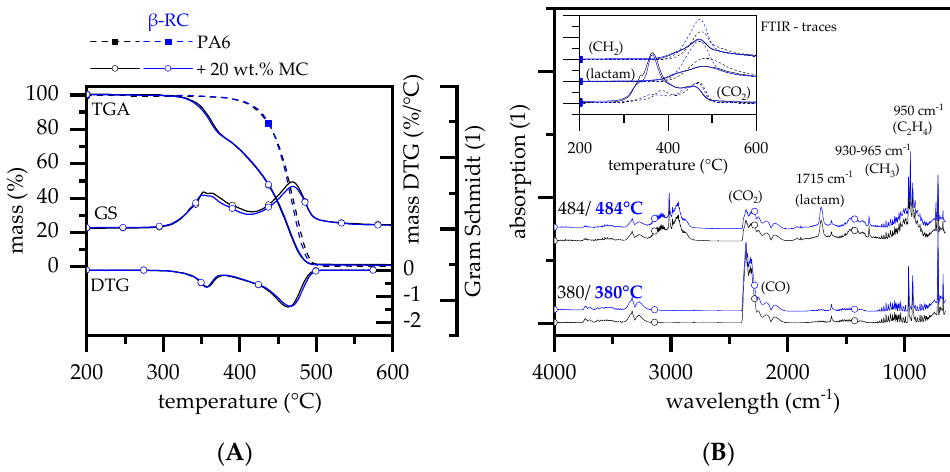
Figure 3. TGA, DTG, Gram Schmidt and FTIR (Gas) curves determined at a heating rate of 20 K/min. ( A ) TGA, DTG Gram Schmidt for PA6 containing 20 wt.% MC; ( B ) corresponding FTIR peak spectra.